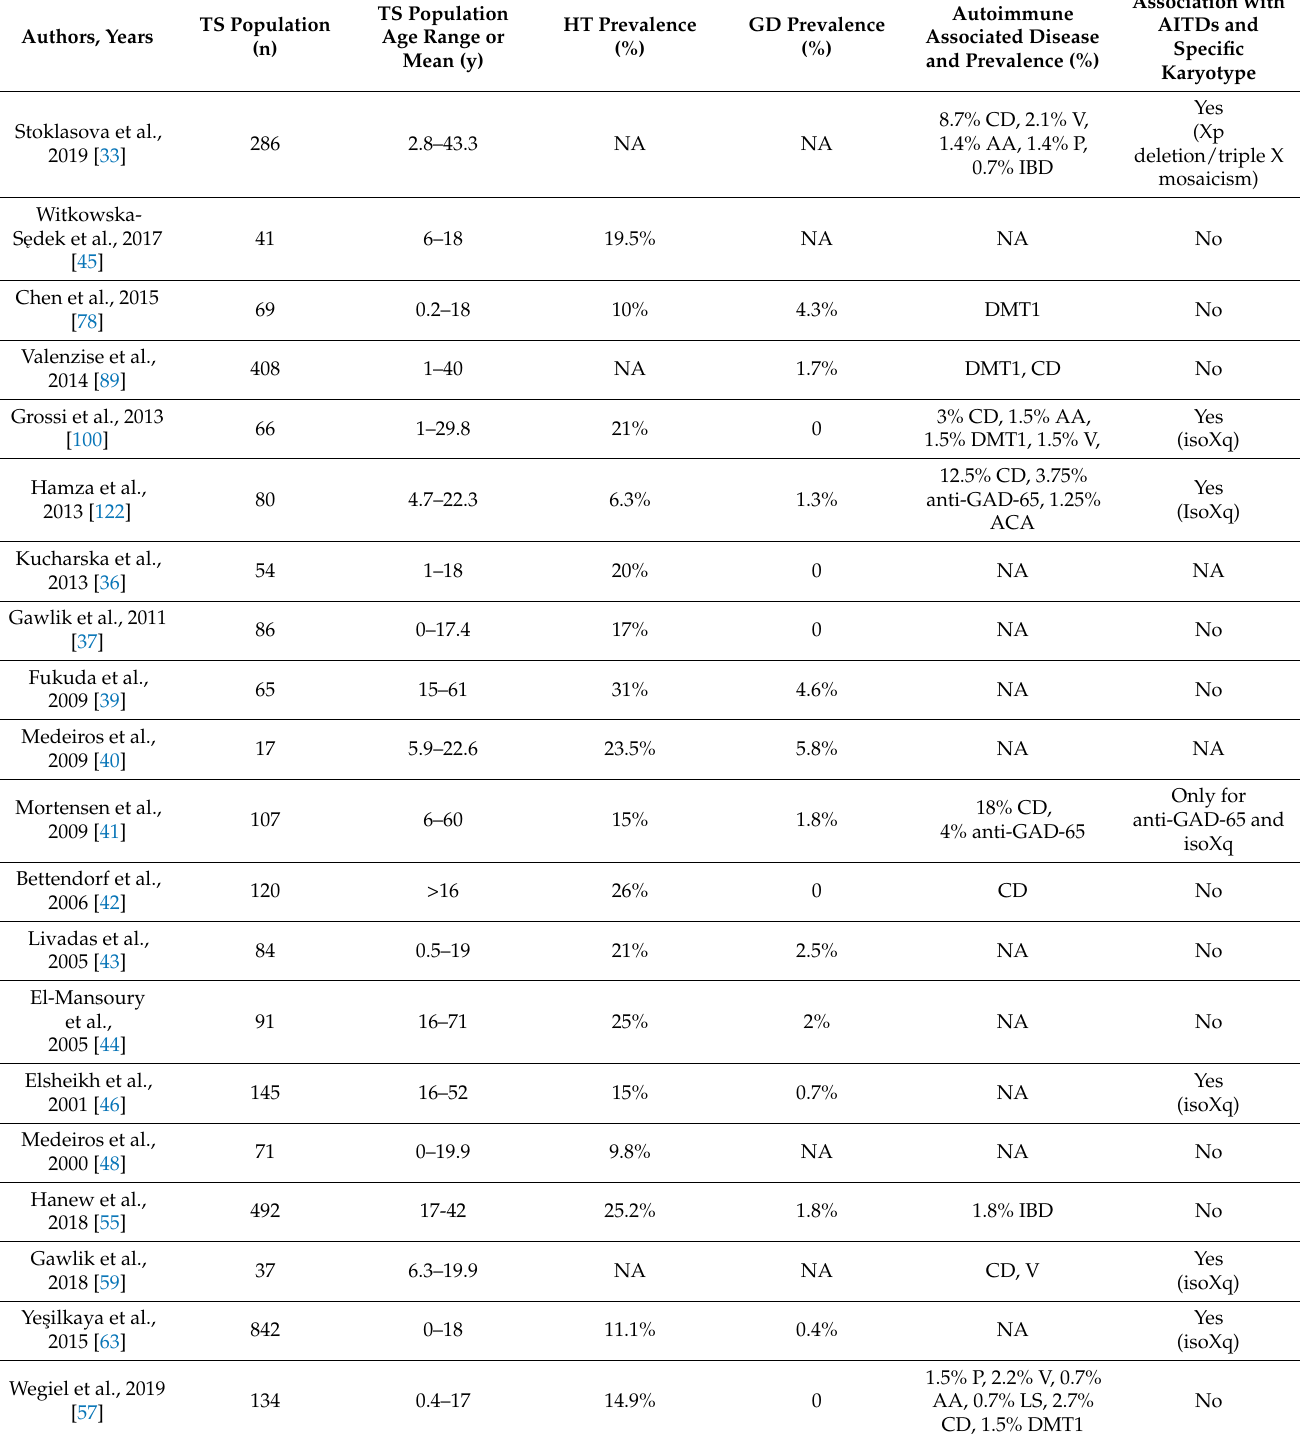
Table 1. Autoimmune thyroid disease (AITD) prevalence, association with karyotype and with other autoimmune diseases, among different studies, in a Turner syndrome